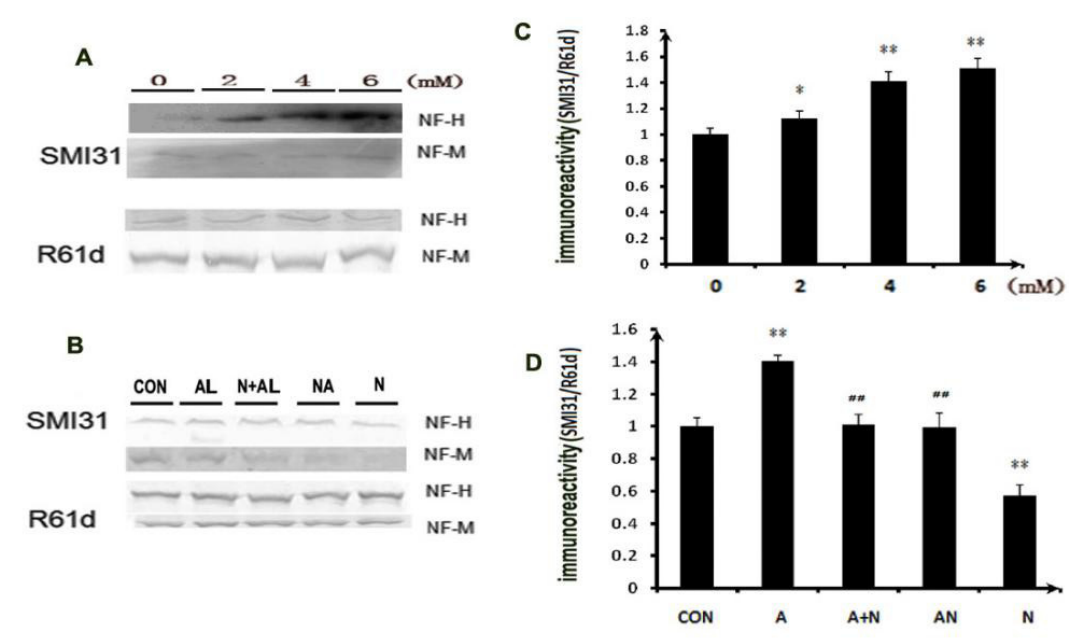
Fig. 2. The abnormal phosphorylation of NFs and accumulation in SK-N-SH cells. A. Representative blots of cells treated with different concentration of alloxan (AL) (0, 2, 4, 6 mM) with specific monoclonal antibodies of SMI31 and R61d recognized the phorsphorylation and total of NF-M/H. B. Representative blots of cells pretreatment with 20 μM NAG-Ae (N+AL) or treated with 20 μM NAG-Ae and 6mM alloxan at the same time (NA) with antibodies of SMI31 and R61d C. and D. The quantities assay of blot A and B * indicated P <0.05 ** P <0.01 compared to the control cells. ## P <0.01 compared to alloxan treated cells for the same treatment